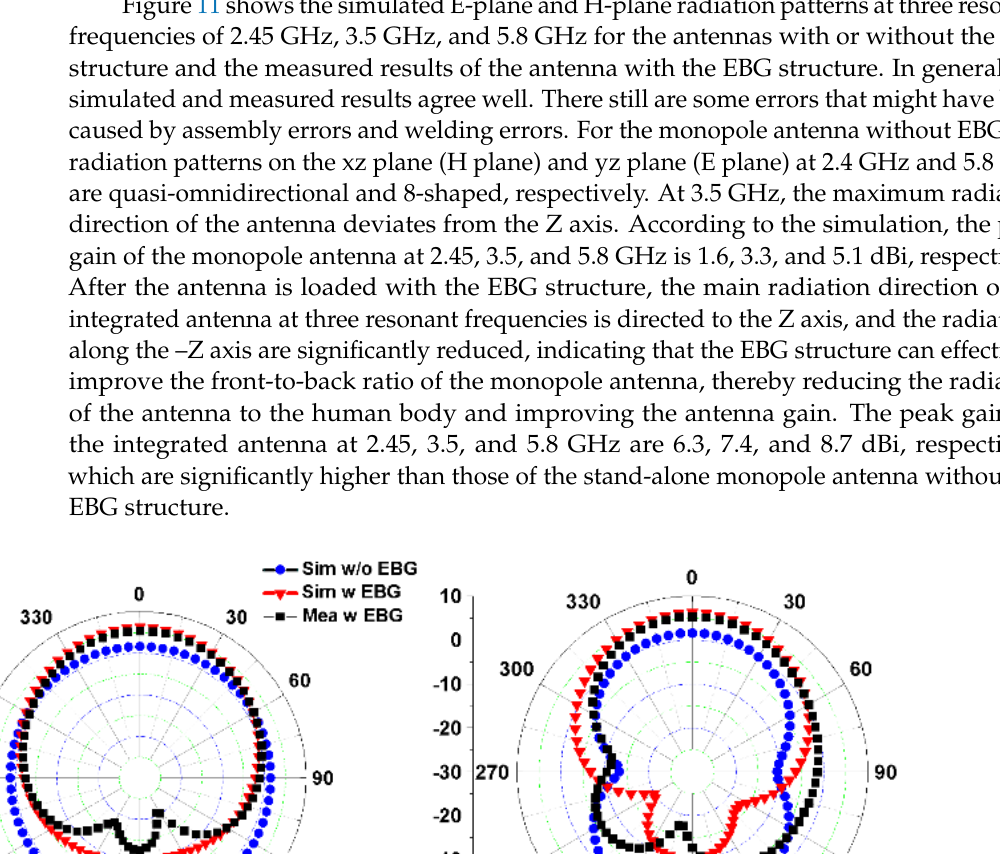
Figure 10. Simulated and measured reflection coefficients of the integrated antenna.